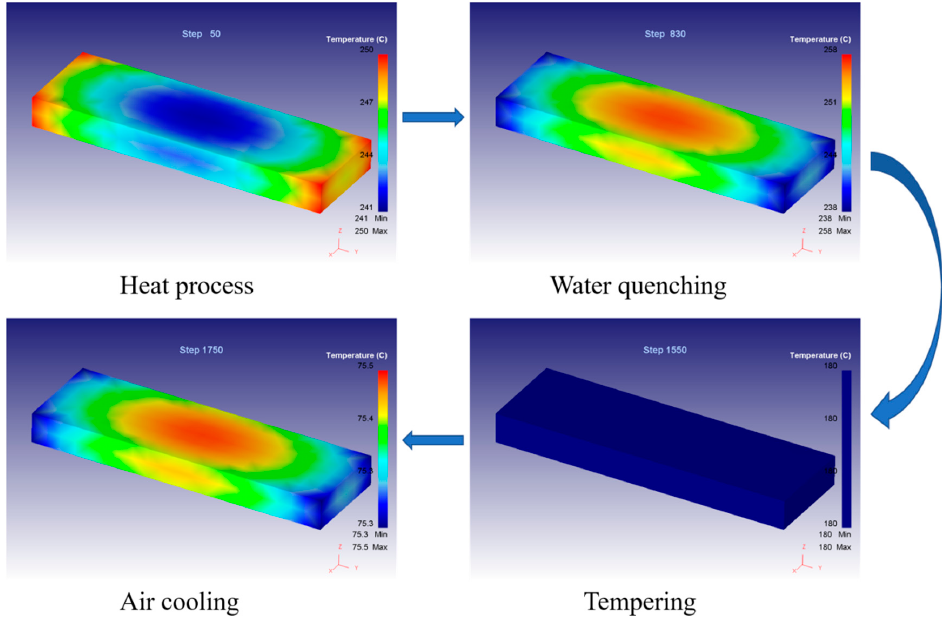
Figure 5. Stages of heat